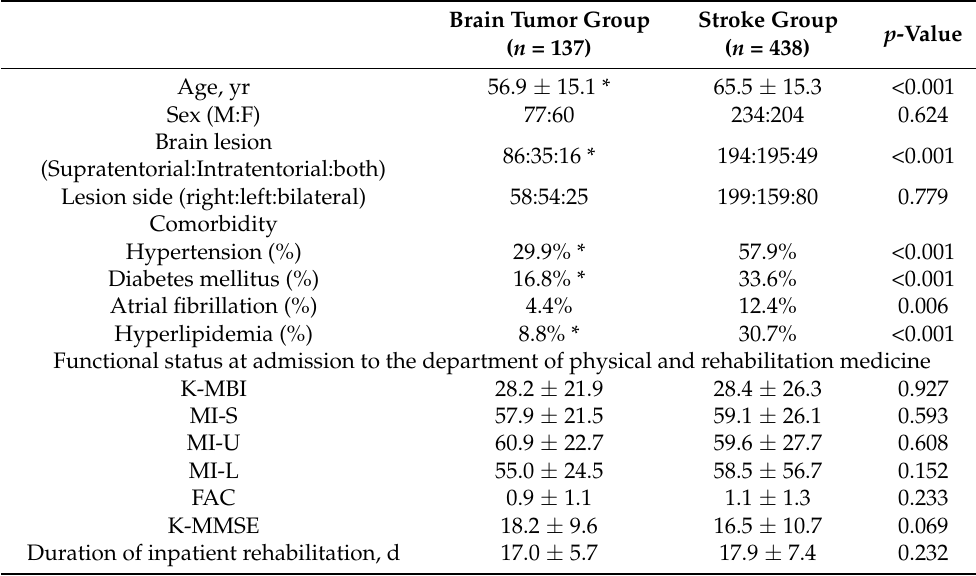
Table 1. General and functional characteristics of patients with brain tumor or stroke. Brain Tumor